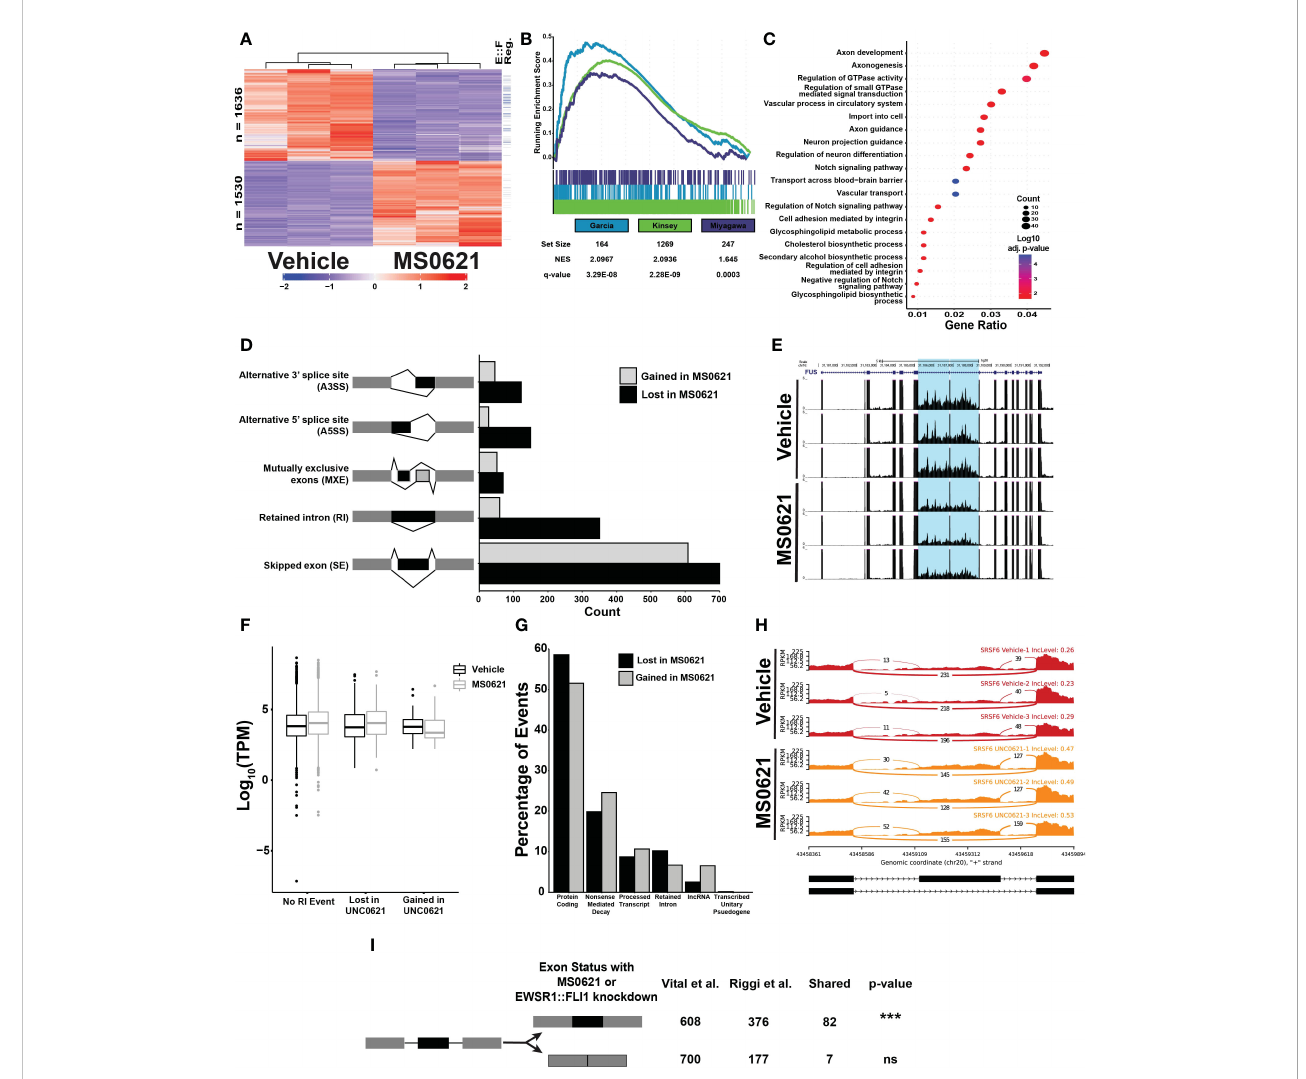
FIGURE 5 MS0621 affects EWSR1::FLI1 regulated genes and in fl uences RNA splicing (A) Heatmap displaying row normalized Z-scores for differentially expressed genes in EWS894 cells following 16 hours of treatment with 5 m M MS0621 or vehicle control (DMSO). The right most column indicates genes also differentially regulated by EWSR1::FLI1 in (30). (B) Gene set enrichment analysis of genes differentially expressed in EWS894 cells following treatment for 16 hours with 5 m M MS0621 or vehicle control (DMSO) using gene sets upregulated by EWSR1::FLI1. (C) Enriched Biological Processes GO terms for genes that were downregulated with MS0621 treatment but not regulated by EWSR1::FLI1. Results shown are the -log 10 adjusted p-value for the top 20 enriched GO terms. (D) Signi fi cant differential alternative splicing events were identi fi ed by rMATS from RNA prepared from EWS894 cells treated 16 hours with 5 m M MS0621 or vehicle control (DMSO). Indicated splicing events were supported by at least 20 reads, an Inclusion Level Difference > 10%, and FDR < 0.05. (E) Differential retention of a tumor-characteristic pair of introns in the FUS gene. Gene tracks represent three replicates each for Vehicle- or MS0621- treated EWS894 cells. (F) Box plots of log10 TPM values for genes with an RI event gained or lost with MS0621 or with no RI event. (G) Percentage of transcript-speci fi c SE events identi fi ed by rMATS annotated by GENCODE biotype. (H) Sashimi plots of differential retention of the SRSF6 poison exon. Sashimi plots represent three replicates each for Vehicle- or MS0621- treated EWS894 cells. (I) Enrichment of SE events gained with MS0621 and EWSR1::FLI1 was assessed by permuting 1,000 times over spliceable exons with minimum read coverage greater than or equal to 20 reads. ***p-value less than